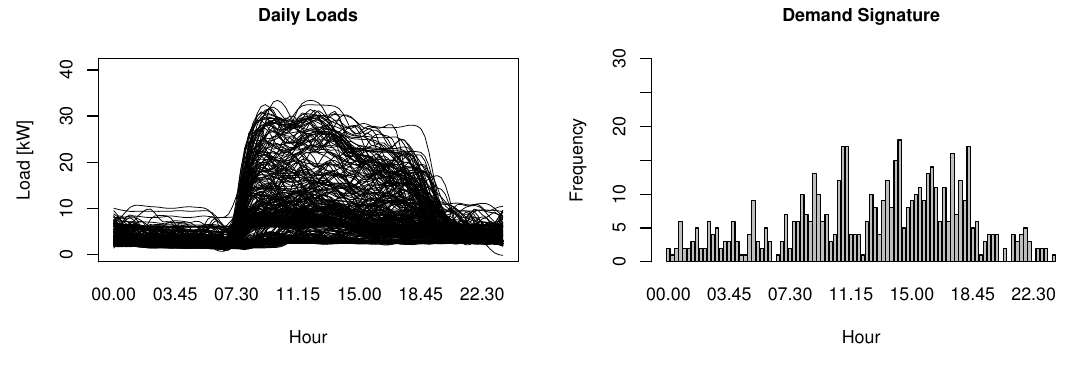
Figure 3. One year of daily load curves superposed and the related electricity demand